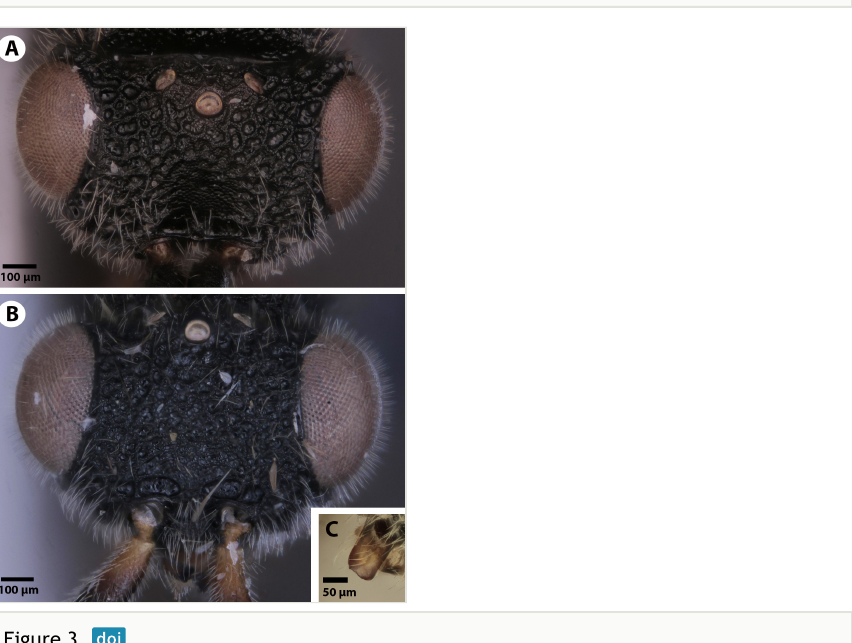
Figure 2. Dorsal view of Dendrocerus scutellaris. A. Male holotype (NHMUK010812028). B. Female paratype (NHMUK010812044).